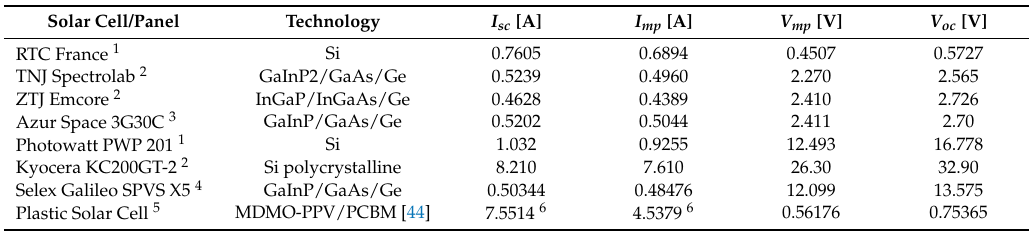
Table 2. Solar cell/panel I – V curves used by the authors to compare explicit expressions (see Table 1). The characteristic points ( I sc , I mp , V mp , and V oc ) for these curves are included in the table.